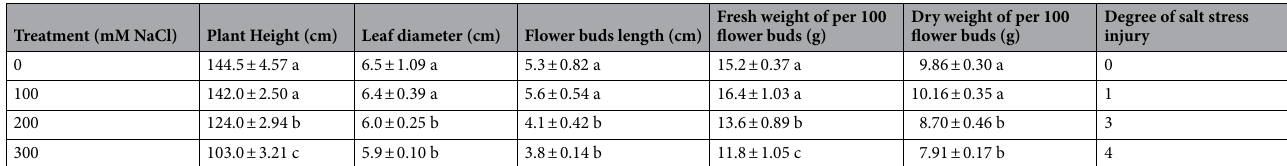
Table 1. Changes in growth parameters of L . japonica under different levels of salt stress (the means ± SD, n =